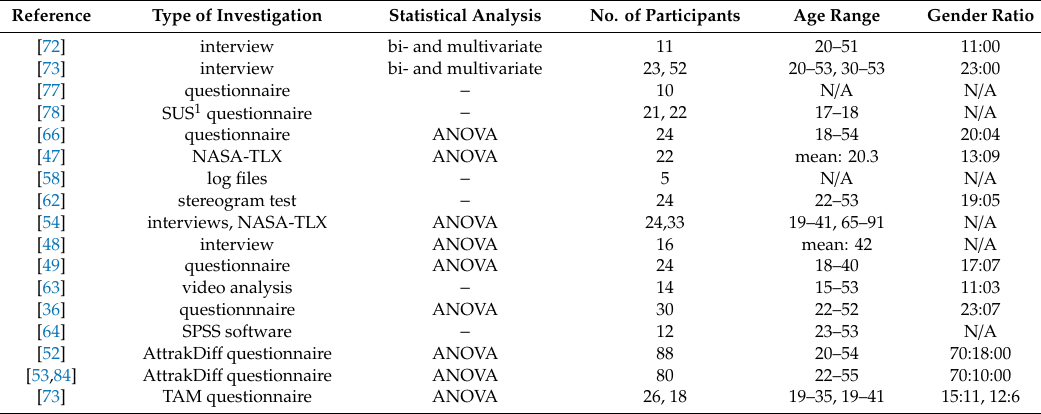
Table 4. List of user studies.